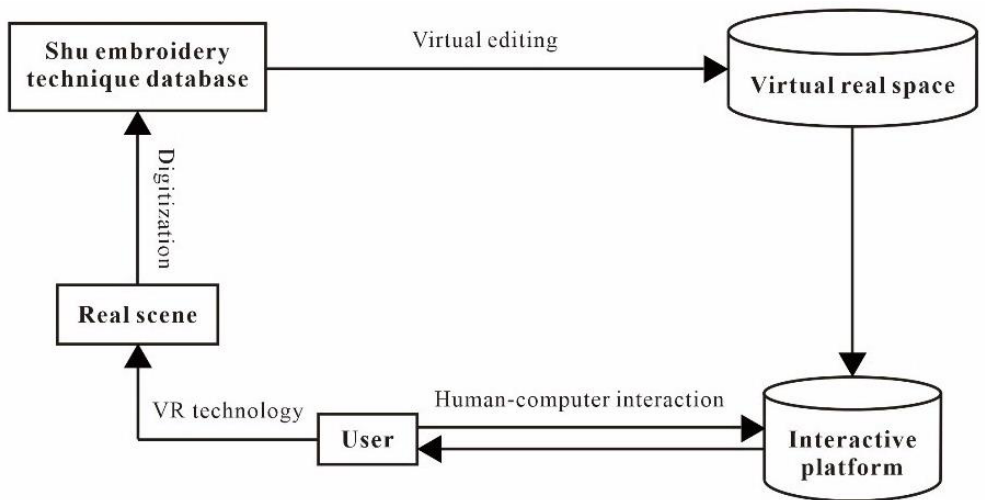
Figure 7. Experience system diagram of Shu embroidery techniques